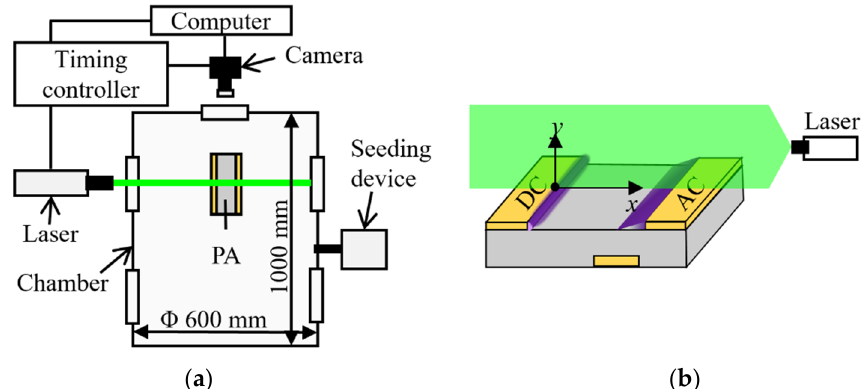
Figure 6. Setup for thrust measurement.